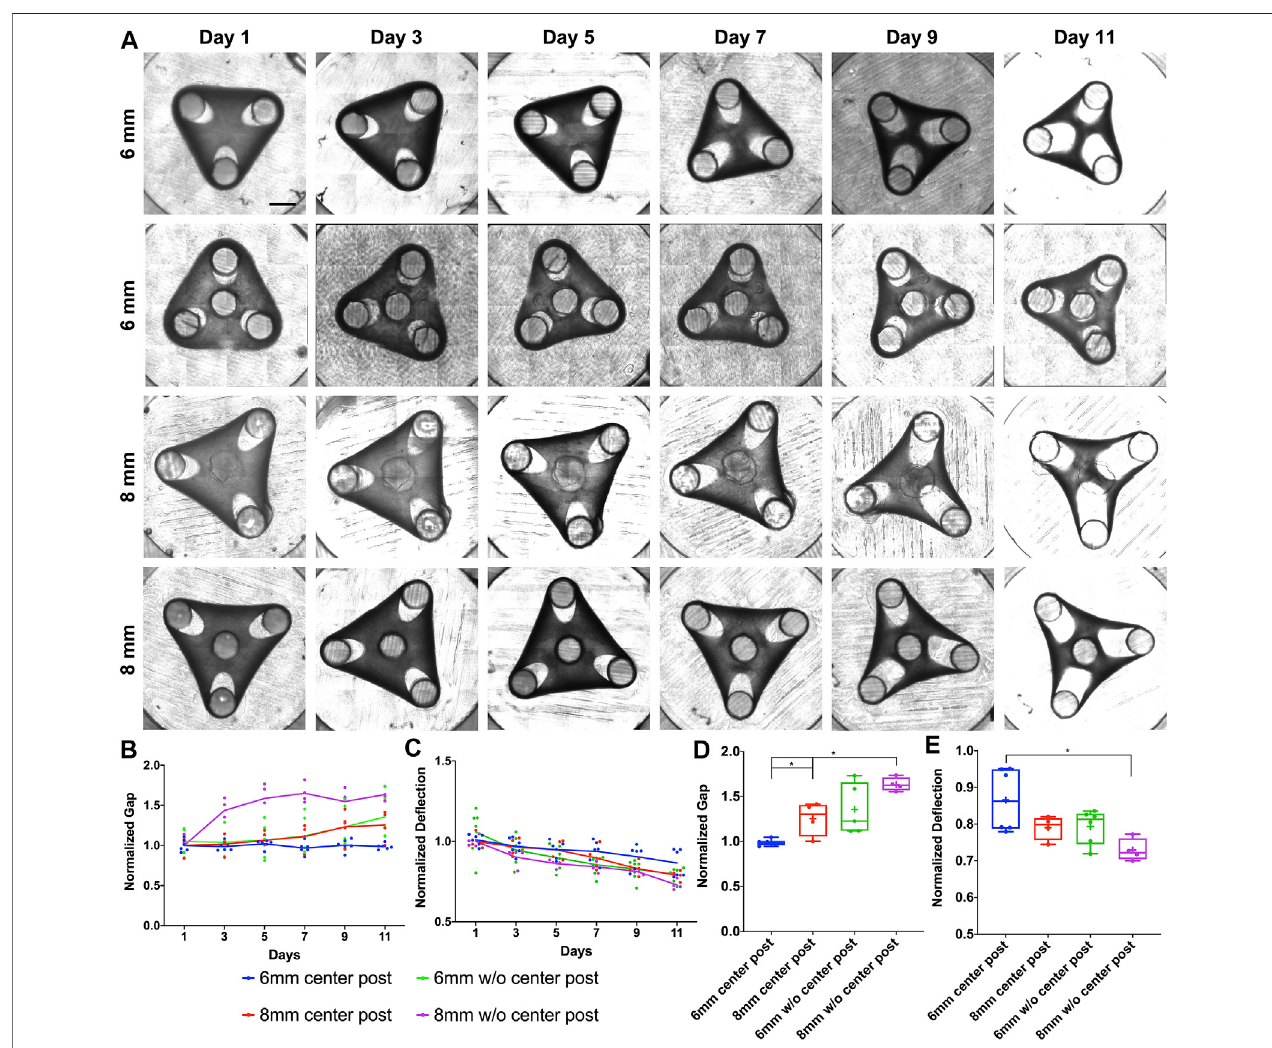
FIGURE1| Experimentalresultsofmorphologicalevolutionoftriangularmesenchymaltissues. (A) Representativeimagesoftissueremodelingover11 daysforthe triangulartissuesofdifferentsidelengthsandwithorwithoutcenterpost. (B) Tissuethinningaroundthepostledtogapextension,and (C) inwardremodelingattheedge led to de fl ection compaction. The gap and de fl ection were measured every 2 days for tissue comparison ( ▲ 6wC, ▲ 8wC, ▲ 6woC and ▲ 8woC). Taking the measurements on Day 11, (D) the gap was larger and (E) the de fl ection was smaller for the triangular tissues with longer side length and without the center post. Scale bar: 1 mm * p <